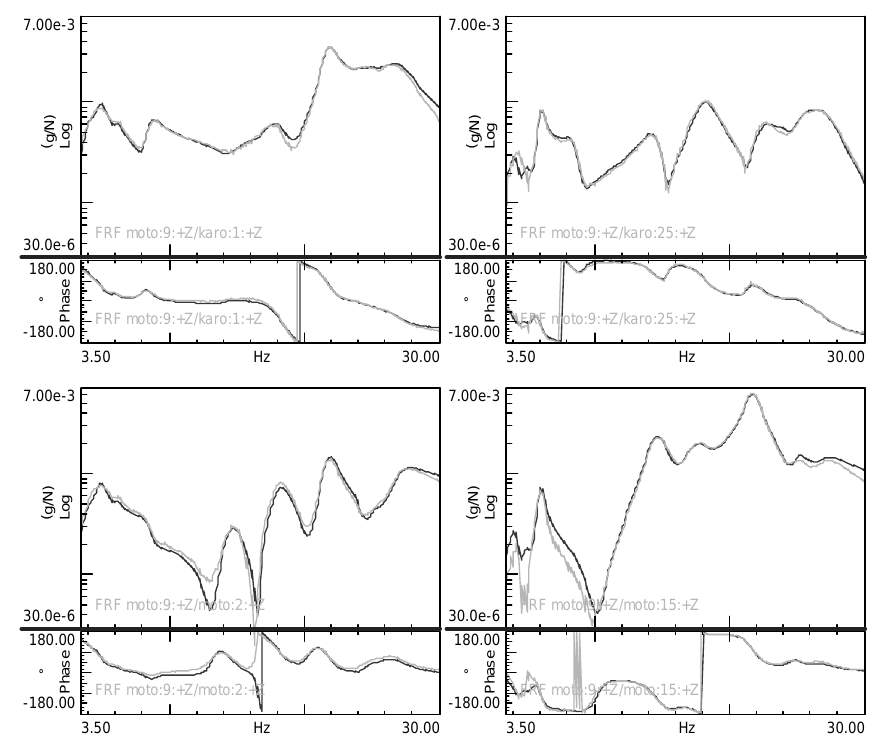
Fig. 3. Comparison of the measured FRFs (grey) with FRFs synthesised from the identified modal model (black). The FRFs between the 4 inputs and 1 typical output are shown. Table 2 Averaged correlations and errors between measured and